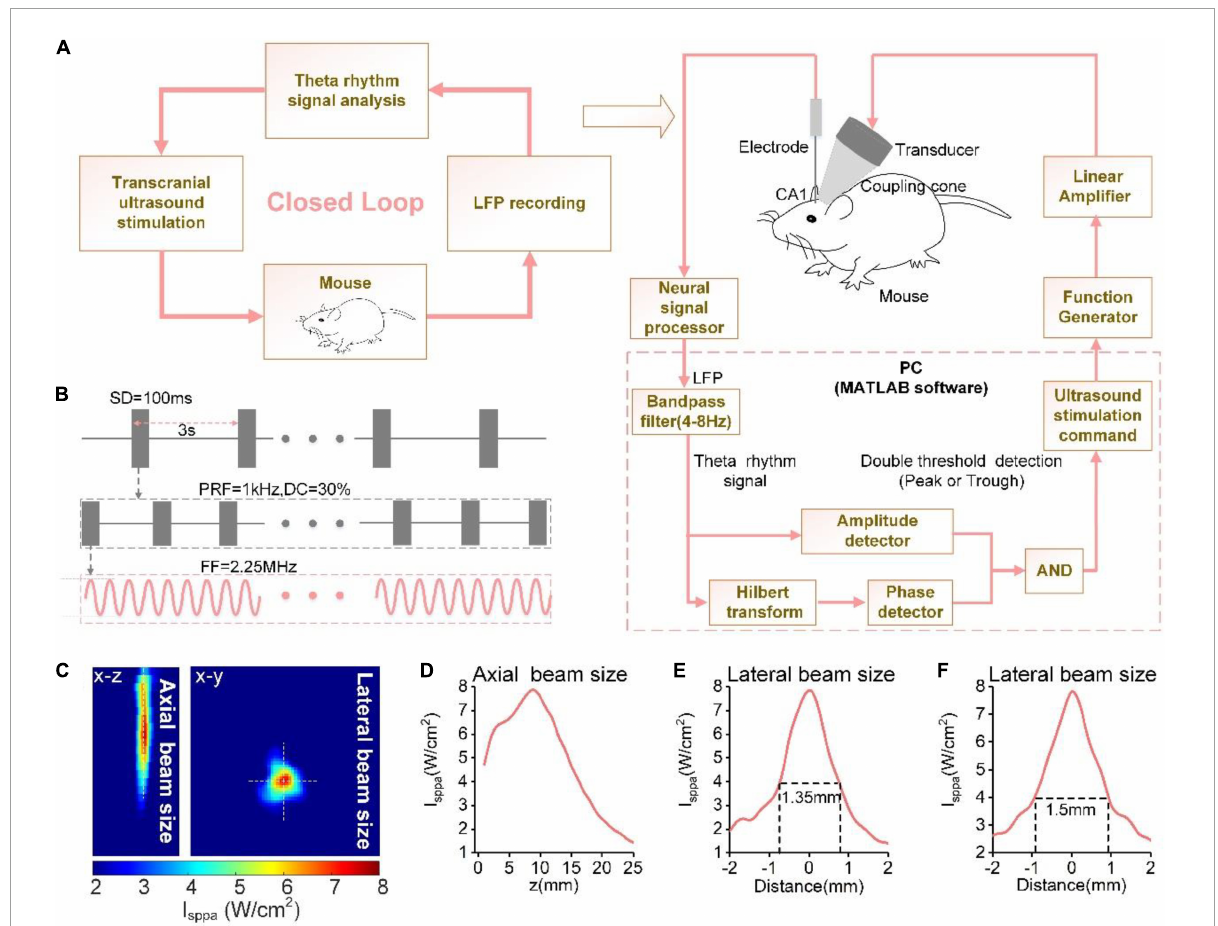
FIGURE1 (A) The schematic of the phase-locked close-loop ultrasound stimulation system. (B) Time sequence of ultrasound stimulation. (C) Ultrasound field distribution under the skull in xy plane. The reconstruction profile along the blue dotted lines. Ultrasound field distribution under the skull in the xz and xy planes. (D–F) The reconstruction profile along the white dotted lines in (C)